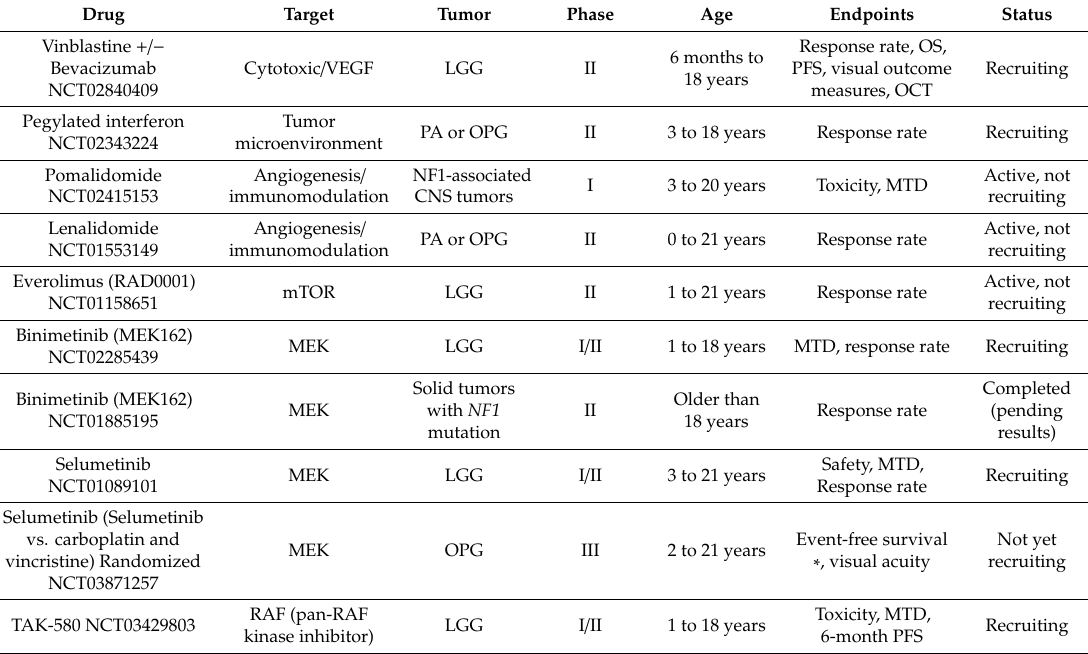
Table 2. Clinical trials for NF1 associated